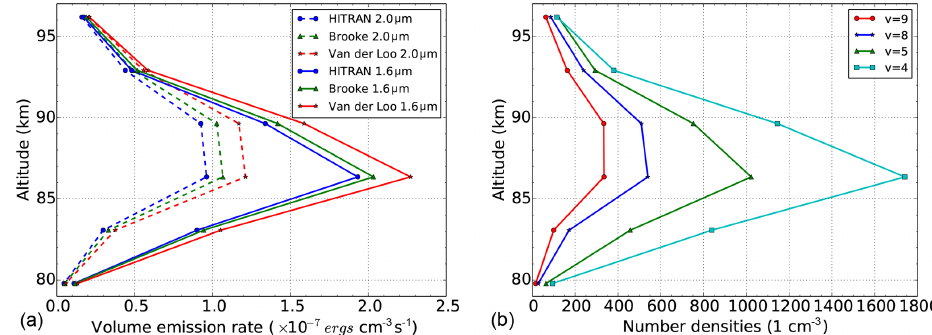
Figure 3. Simulated SABER unfiltered OH 1.6 and 2.0µm volume emission rates from SCIAMACHY data using Einstein A values of HITRAN, Brooke et al. (2016), and van der Loo and Groenenboom (2007, 2008) at 20–40 ◦ N for October 2007 (a) ; Corresponding retrieved OH number densities of vibrational states 9, 8, 5, and 4 from SCIAMACHY data using HITRAN database (b) .